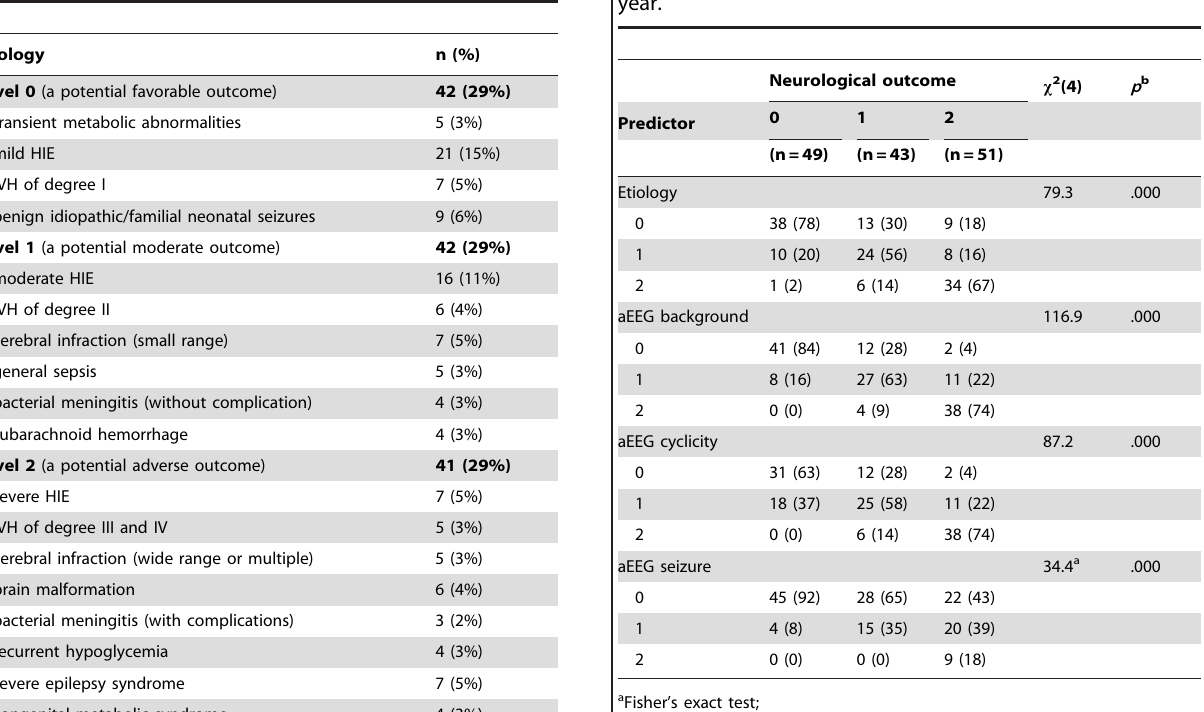
Table 1. Etiologic distribution of neonatal seizures in this study.